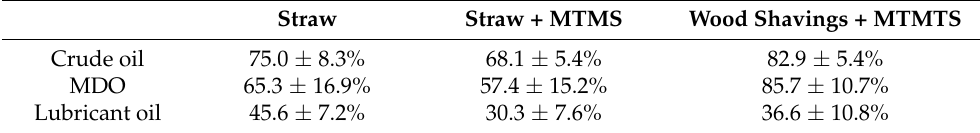
Table 4. Recovery of different kinds of oil concerning the different sorbents on day 14.